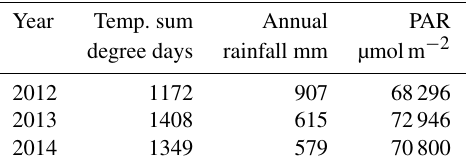
Table 1. Effective temperature sum of the growing season, annual rainfall and the amount of photosynthetically active radiation (PAR) in the three studied years 2012–2014. Temp.